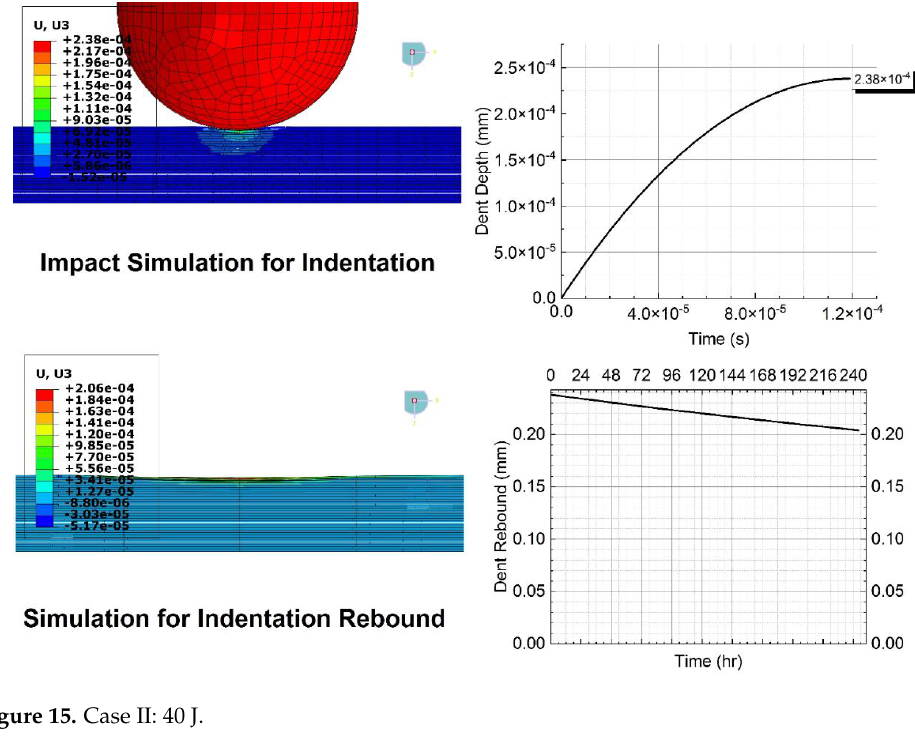
Figure 14. Case I: 50 J.